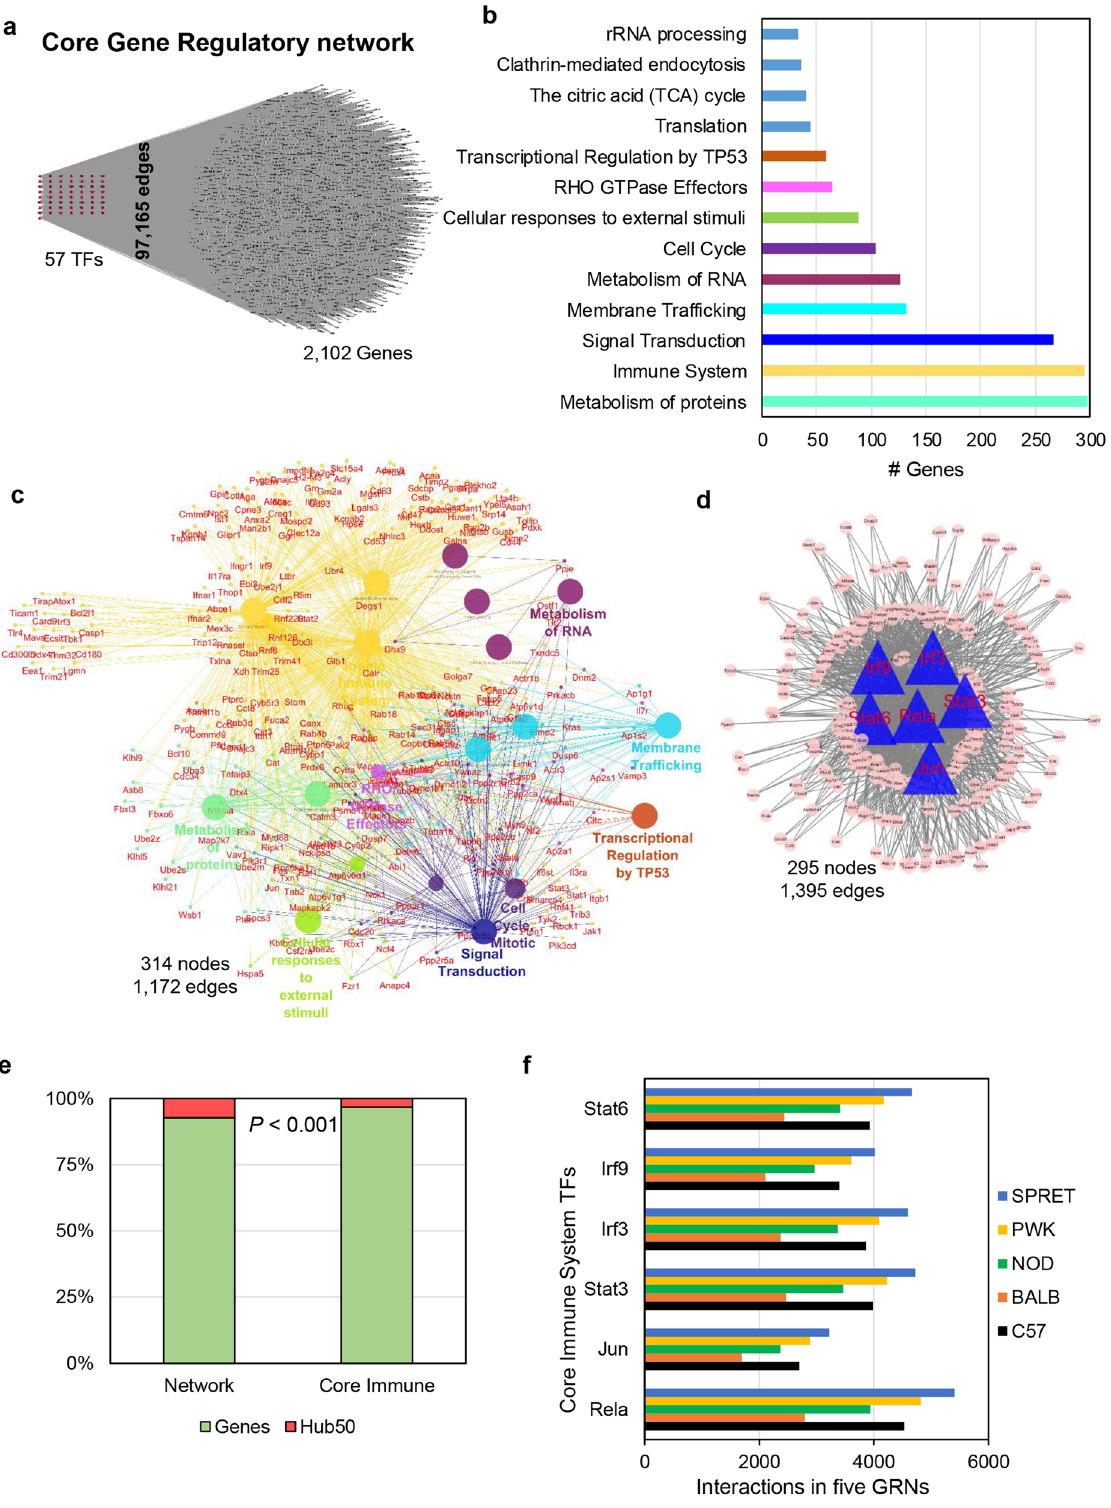
Figure 6. Immune system and signal transduction GRNs are statistically conserved across unstimulated macrophage of five diverse murine strains. ( a ) The merger of five consequential GRNs predicts the core GRN (97,165 edges with 2159 nodes) conserved across five strains of mice. The core GRN has 57 TFs and 2102 genes. ( b ) Gene and pathway ontology of core GRN nodes by ClueGO revealed some of the significantly enriched ontology terms; protein metabolism, immune system, signal transduction, membrane trafficking, RNA metabolism, cell cycle, cellular responses to external stimuli, RHO GTPase effectors, and transcriptional regulation by TP53 ( P ≤ 0.001) (Supplementary Figure S3). ( c ) The immune system ontology gene network is shared with other significant ontologies. Signal transduction and membrane trafficking have the most common genes involved with the immune system. ( d ) Core immune system GRN (1395 edges with 295 nodes). There are six TFs (Stat3, Jun, Stat6, Rela, Irf9, and Irf3) involved in core immune GRN. ( e ) Core immune genes are significantly enriched in Hub 50 (Hypergeometric enrichment test, P < 0.001) representing their importance in the robustness of the co-expression network. ( f ) The interactions of the core GRN immune system TFs in five strain-specific